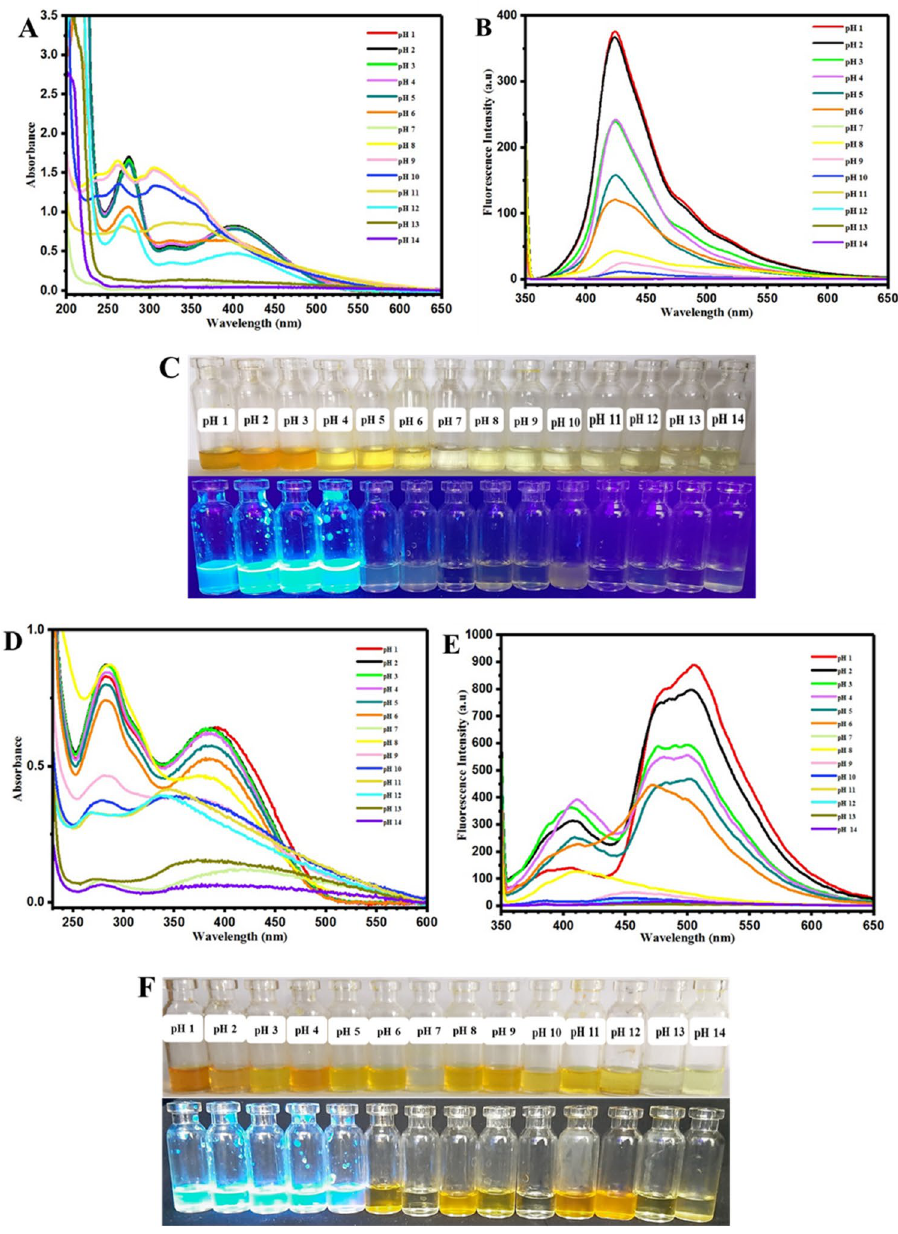
Figure 9. Photodetection of pH using UV–Vis and fluorescence spectroscopies for ( A ) and ( B ) OX 1 -Naph and ( D ) and ( E ) OX 2 -Naph solutions and also photographic images of colorimetric and fluorometric properties of ( C ) OX 1 -Naph and ( F ) OX 2 -Naph at pH of